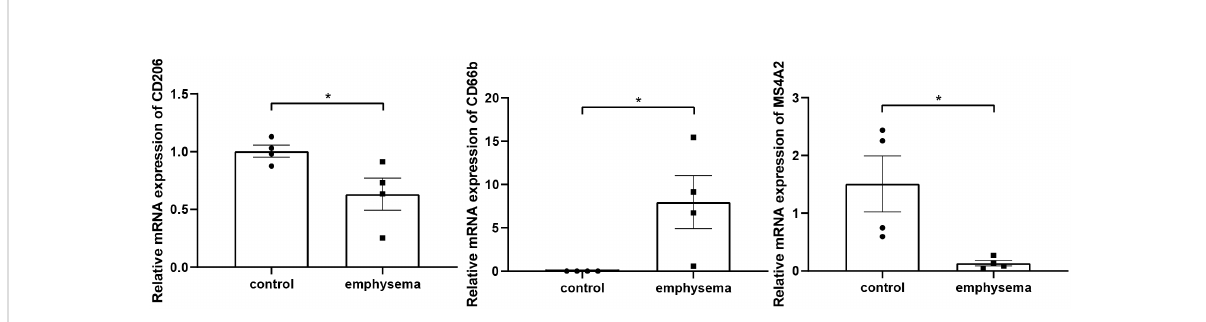
FIGURE 14 The relative expression level of markers of key tissue-in fi ltrating immune cells in emphysematous lung tissues and control tissues. * indicates p < 0.05,